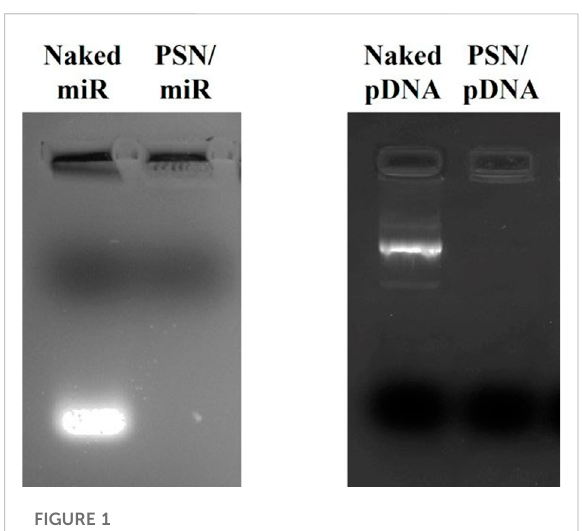
FIGURE 1 1% agarose gel electrophoresis (80 V, 40 min) to evaluate